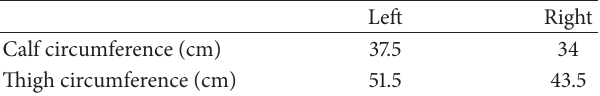
Table 1: Calf and thigh circumferences of the patient’s lower